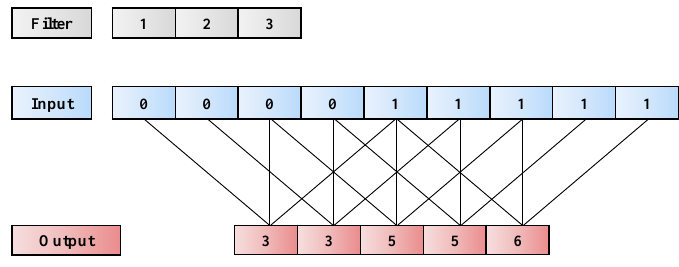
Figure 6. Example of 1D dilated causal convolution (filter size = 3, stride = 1, dilation rate = 2, zero padding =